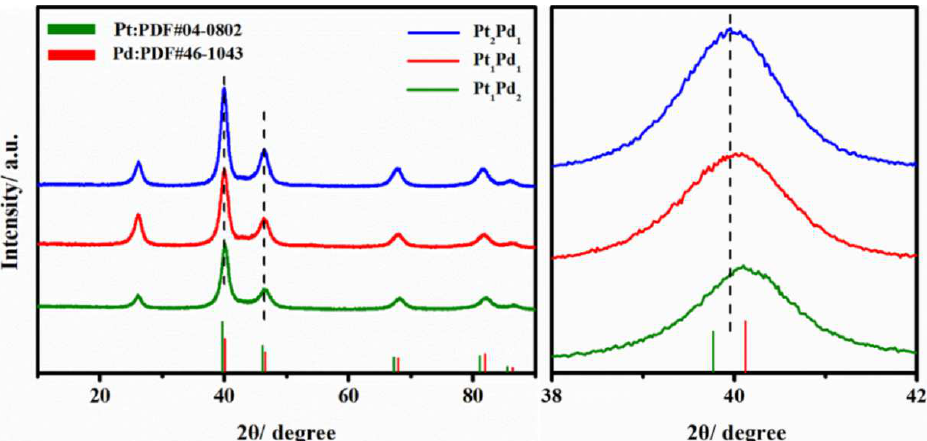
Figure 2. XRD patterns of Pt 2 Pd 1 NCs/MWCNTs, Pt 1 Pd 1 NCs/MWCNTs and Pt 1 Pd 2 NCs/MWCNTs.